Question: Condense the content of this figure into a single sentence.
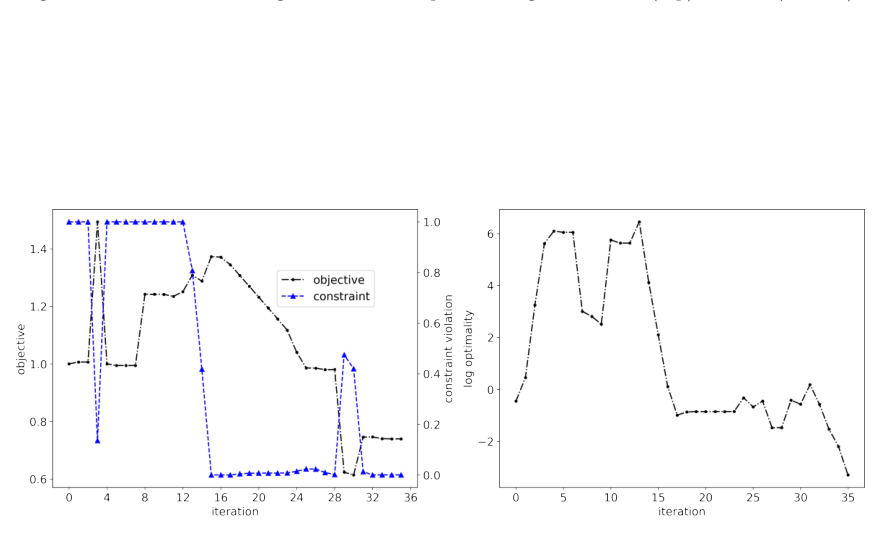
Answer: Optimization result for the wedge problem. The objective and constraint violation values are plotted on the left. The logarithm dual optimality measure is given on the right.